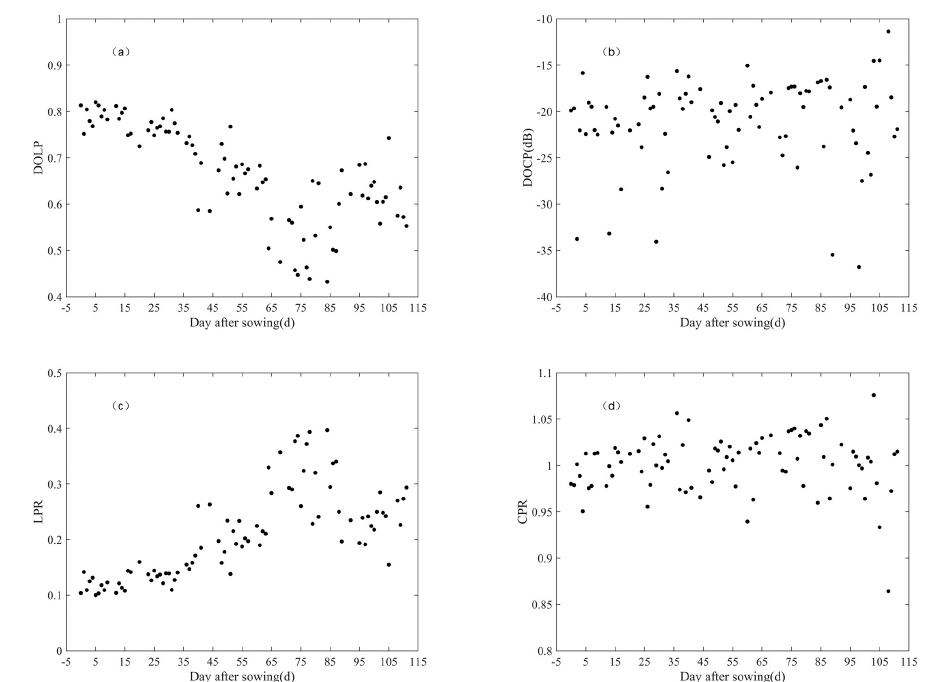
Figure 8. The Group 1 Dolp , Docp , Lpr and Cpr on the evolution of rapeseed phenology.